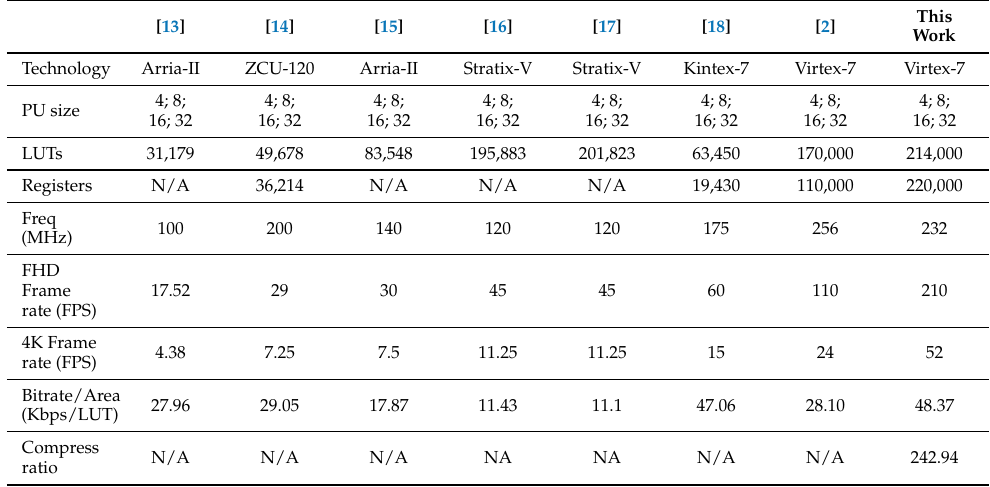
Table 5. Synthesis results and comparison with the other FPGA implementations.